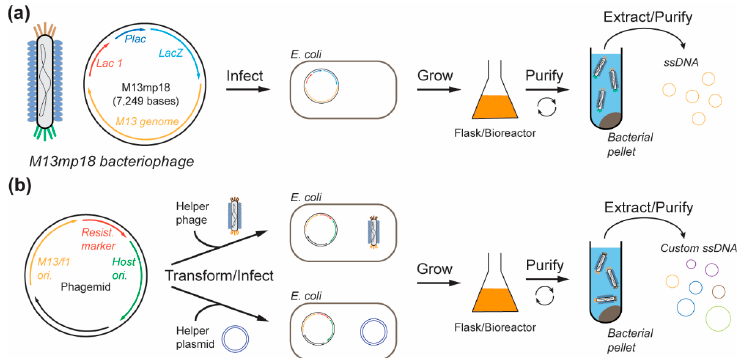
Figure 2. Bacteriophage-based methods for DNA origami scaffold production. ( a ) M13mp18 is used to infect E. coli bacteria where it can replicate and form progeny phages that are released into the culture medium, extracted, and purified to yield single strands of DNA (ssDNA) scaffolds. ( b ) Custom ssDNA scaffolds (lengths and sequences) are encoded into phagemid along with other essential genes for replication. The phagemid is used to transform the host E . coli in the presence of a helper phage or a helper plasmid. The transformed/infected host cells are grown, and the extruded progeny phages containing target ssDNA are extracted from the medium.